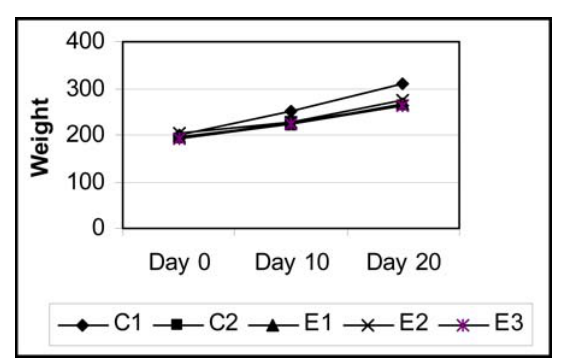
Figure 4 depicts weight variations during pregnancy.